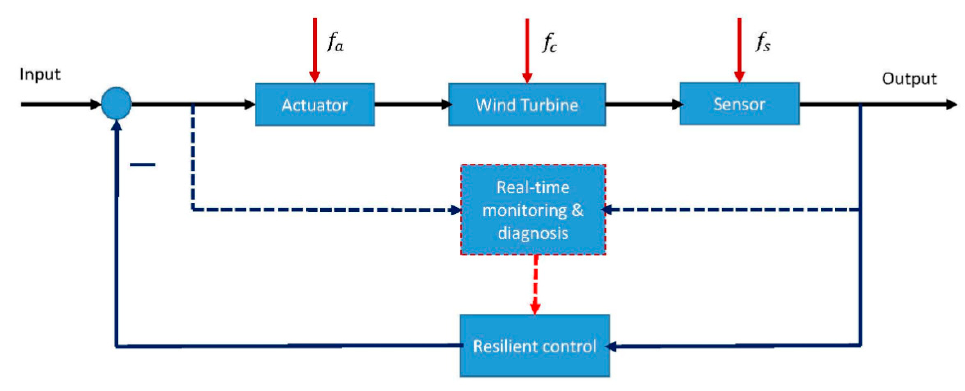
Figure 8. Schematic diagram of resilient control.